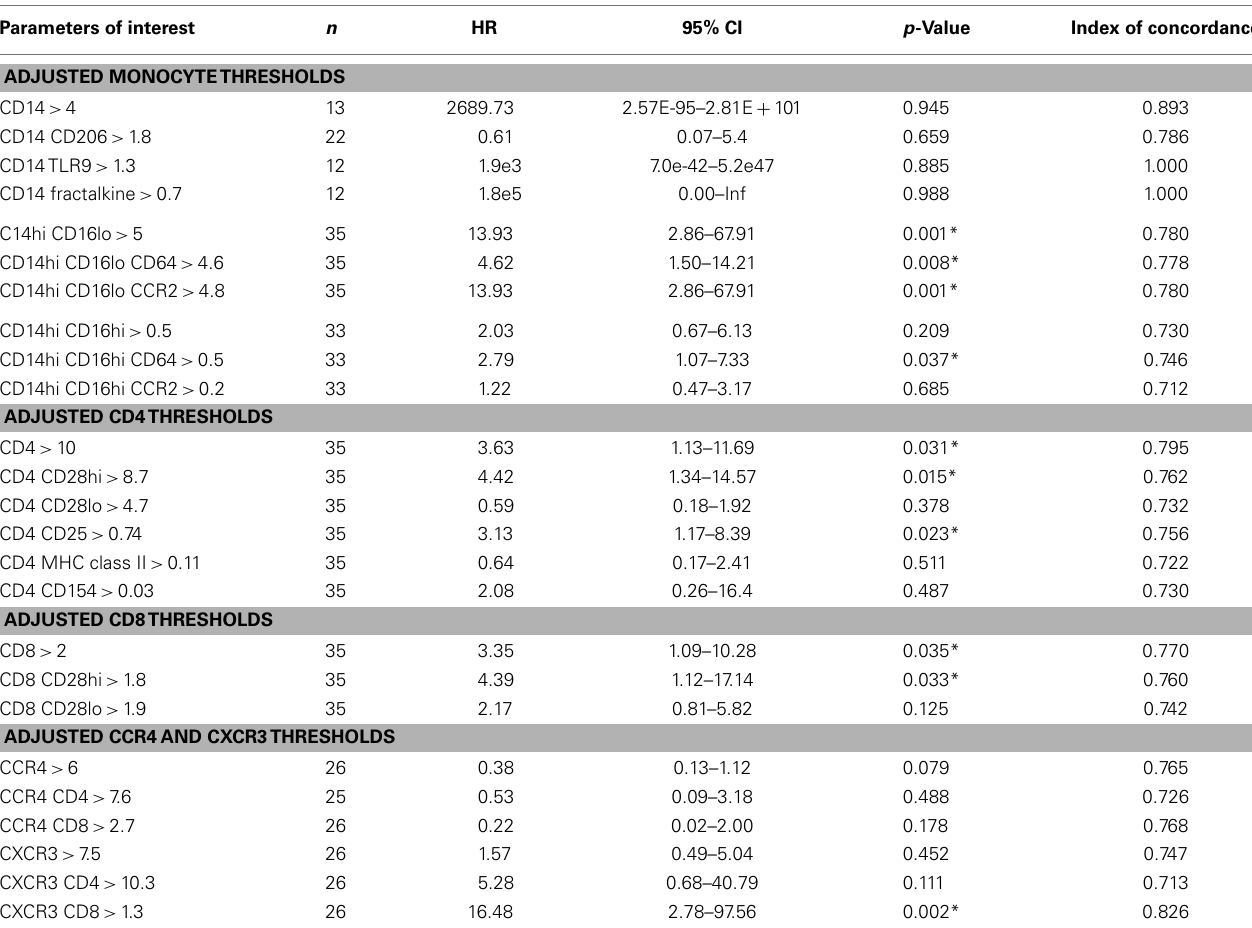
Table 5 |Threshold-based analyses of biomarker levels and association between reaching the combined endpoint adjusted for age,